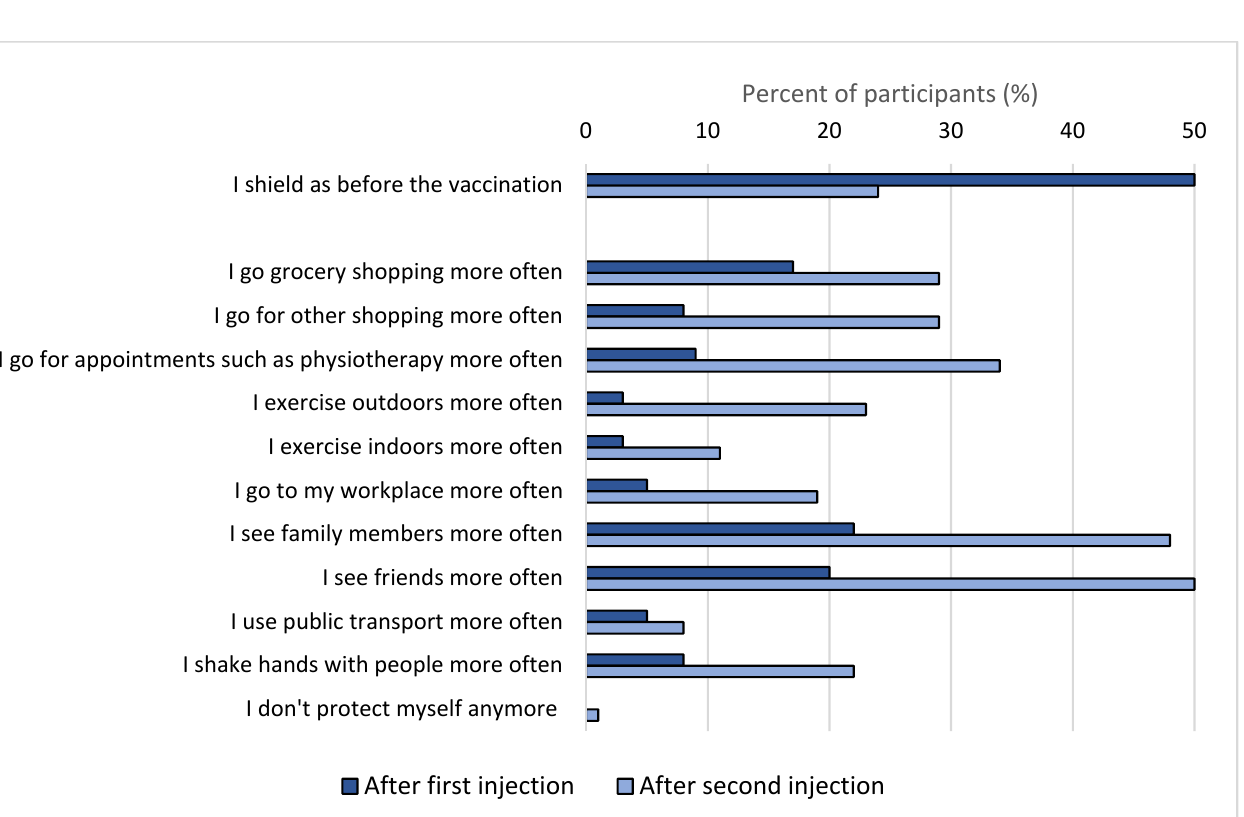
Figure 4. Proportion of participants who reported how they changed their social behaviour after first and second vaccina- tions compared to before getting vaccinated ( n = 282) (COVID-PCD study, May 2021).